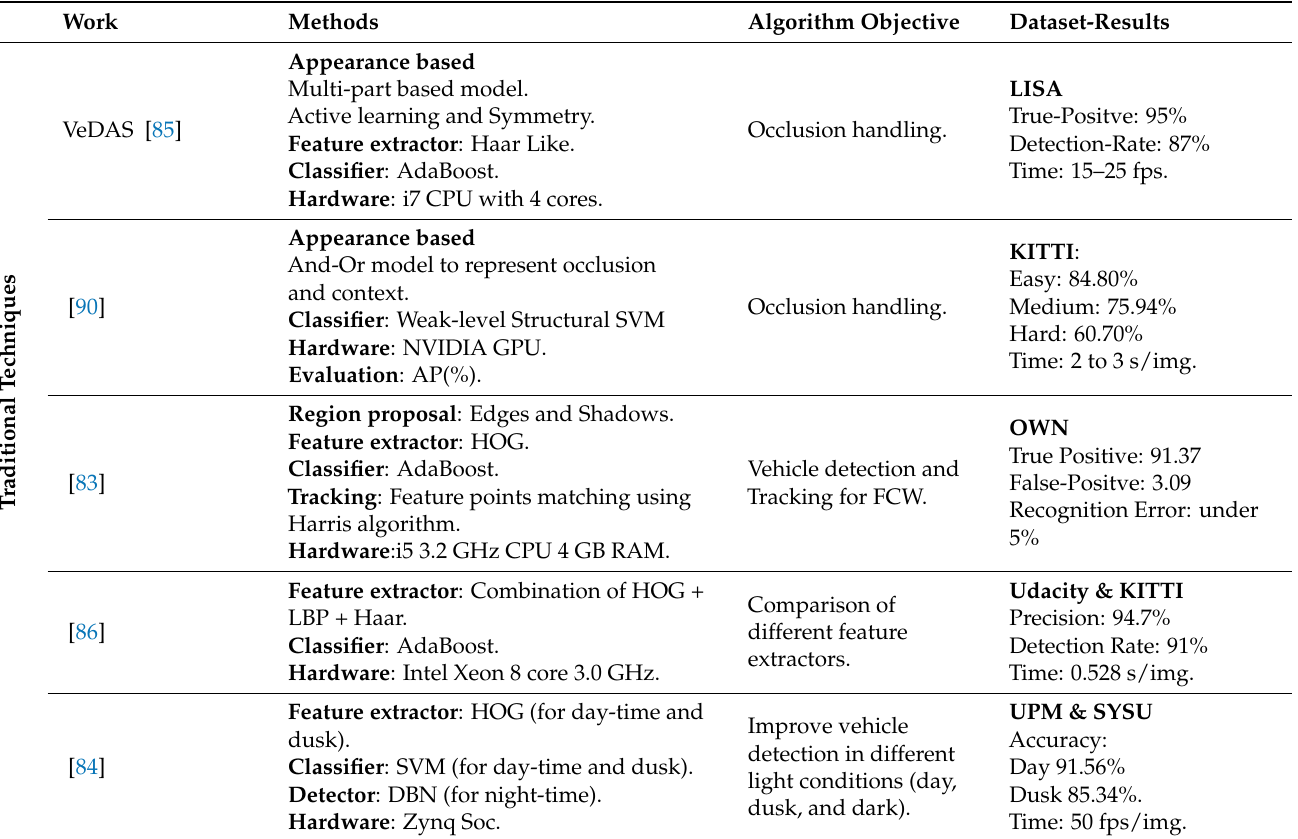
Table 4. Relevant vehicle detection works using traditional and DL techniques. Work Methods Algorithm